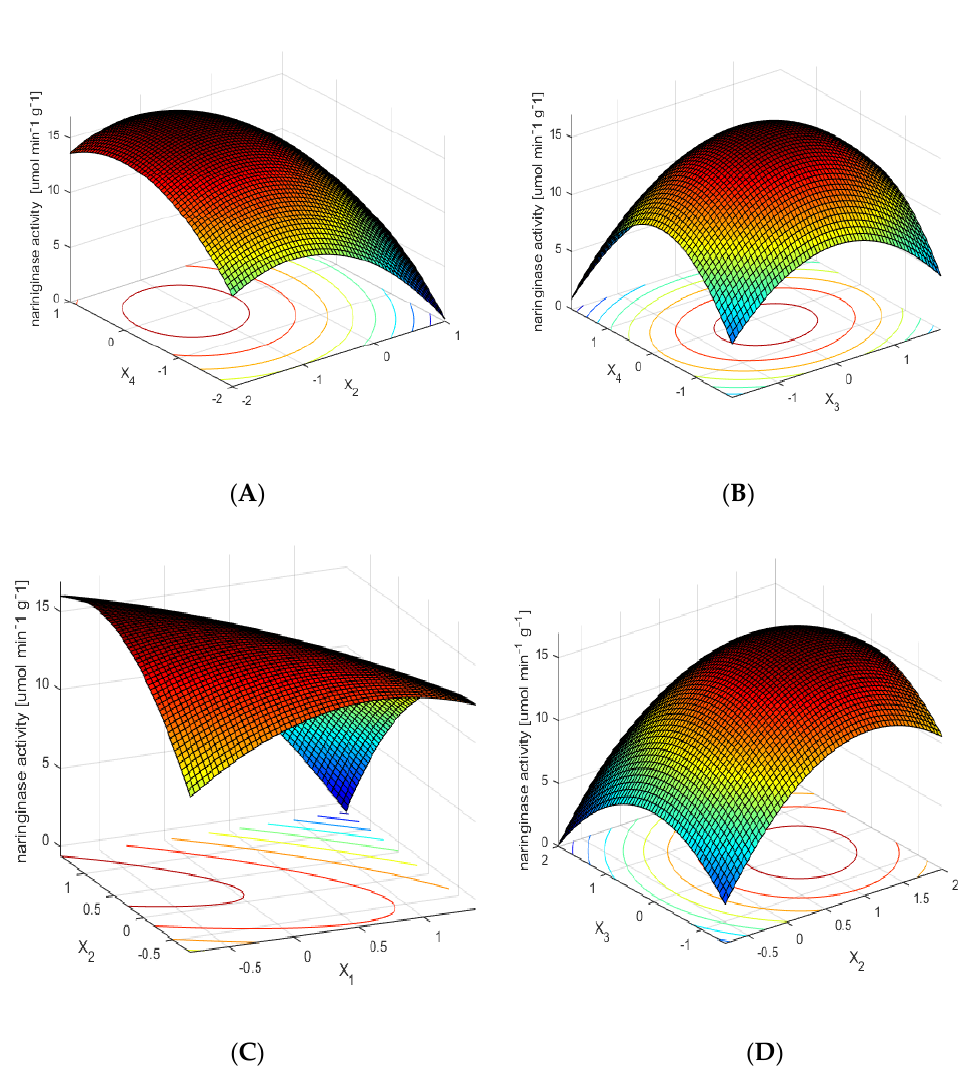
Figure 1. Effect of pH (x 1 ), immobilization time (x 2 ), protein concentration used for immobilization (x 3 ) and immobilization temperature (x 4 ) on the activity of immobilized naringinase from A. niger KMS. The parameters of the immobilization process were expressed in nondimensional values. Each figure shows the dependence of activity on two factors, with the other optimal values. ( A ) Effect of immobilization time (x 2 ) and immobilization temperature (x 4 ) on the activity of immobilized naringinase from A. niger KMS. ( B ) E ff ect of protein concentration used for immobilization (x 3 ) and immobilization temperature (x 4 ) on the activity of immobilized naringinase from A. niger KMS. ( C ) E ff ect of pH (x 1 ) and immobilization time (x 2 ) on the activity of immobilized naringinase from A. niger KMS. ( D ) E ff ect of immobilization time (x 2 ) and protein concentration used for immobilization (x 3 ) on the activity of immobilized naringinase from A. niger